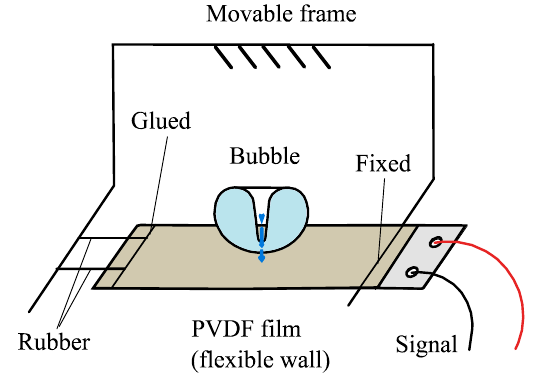
Fig. 2. Flexible wall arrangement.